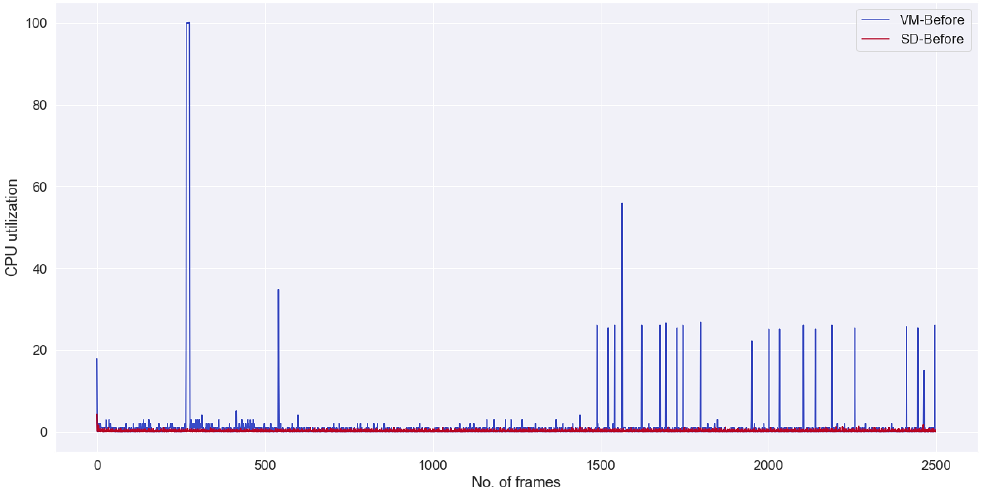
Figure 11. CPU utilization in VM and standalone machine before installing OpenStack.